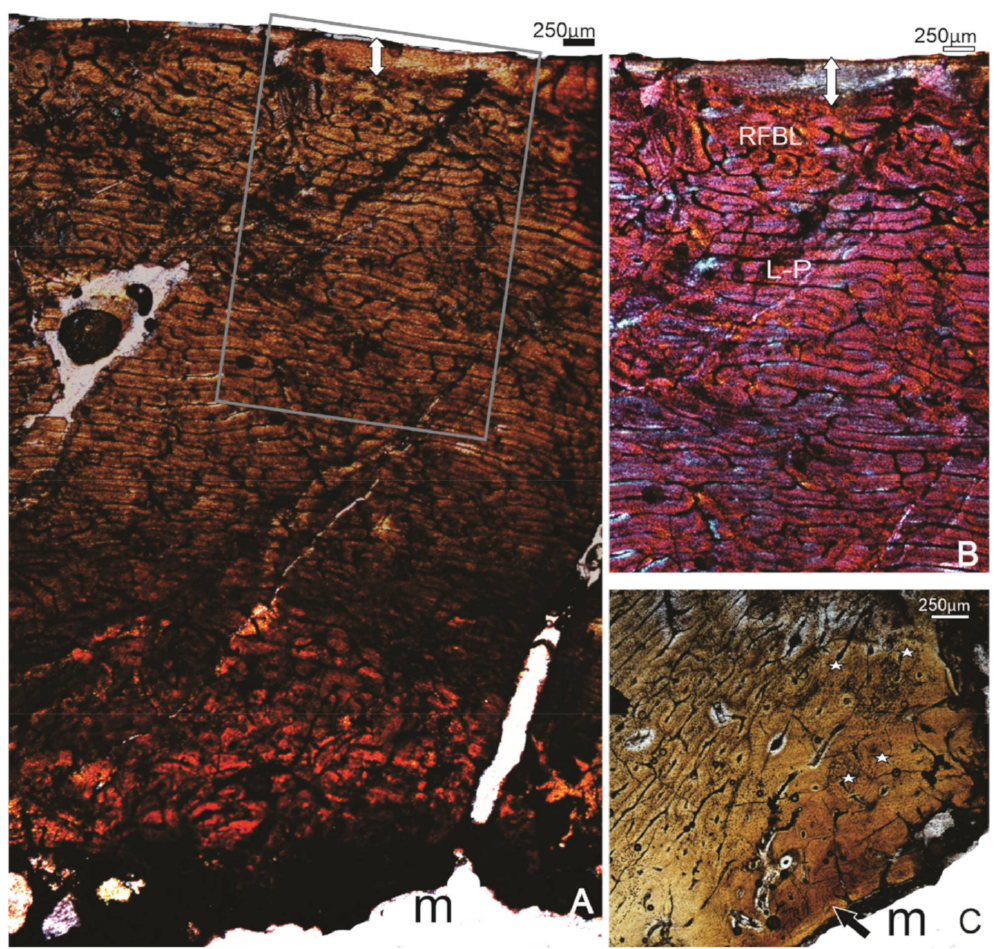
Figure 3. Specimen SAM P.54333; tibiotarsus. ( A ) Overview of the histology of the bone wall. ( B ) Higher magnification of the framed region in ( A ), showing the OCL (double-headed arrow) below which is a band of reticular organised FBL(RFLB), and the more laminar-plexiform (L-P) organised bone tissue deeper in the compacta. ( C ) A view of the perimedullary region showing a narrow ICL (arrow), and some remnants of the early formed reticular bone tissue, secondarily enlarged vascular canals and a few secondary osteons (stars). m, medullary